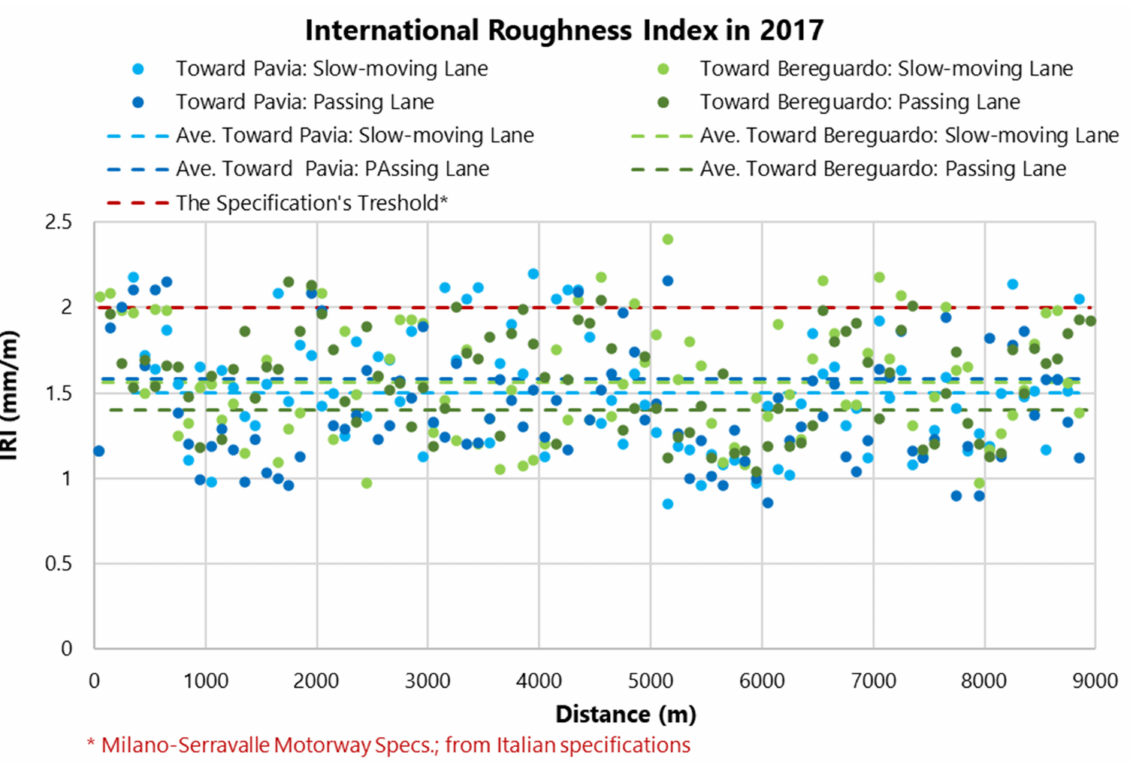
Figure 10. The International Roughness Index (IRI) after 2 years of pavement